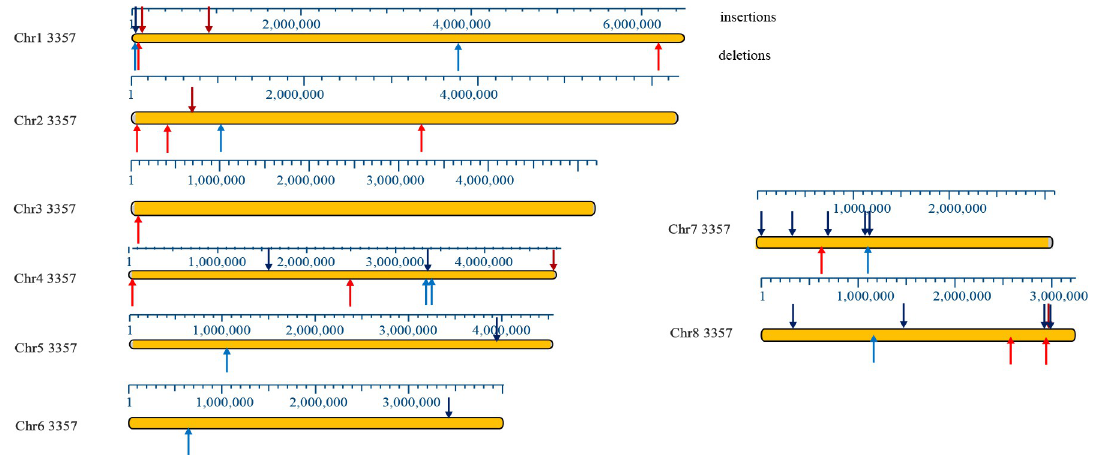
Fig 2. Telomere-to-telomere analysis of CA14/NRRL 3357 AT indels in A . flavus chromosomes. dark red (insertions, above) arrows, and non-AT indels are shown as blue (deletions, below) or black (insertions, above) arrows. CEN 3 and CEN5 are transposed due to the translocation between chromosomes 3 and 5 in CA14. In comparisons of NRRL 3357 and CA14, I used the NRRL 3357 nomenclature for simplicity. Scales in kb are drawn above each chromosome image.